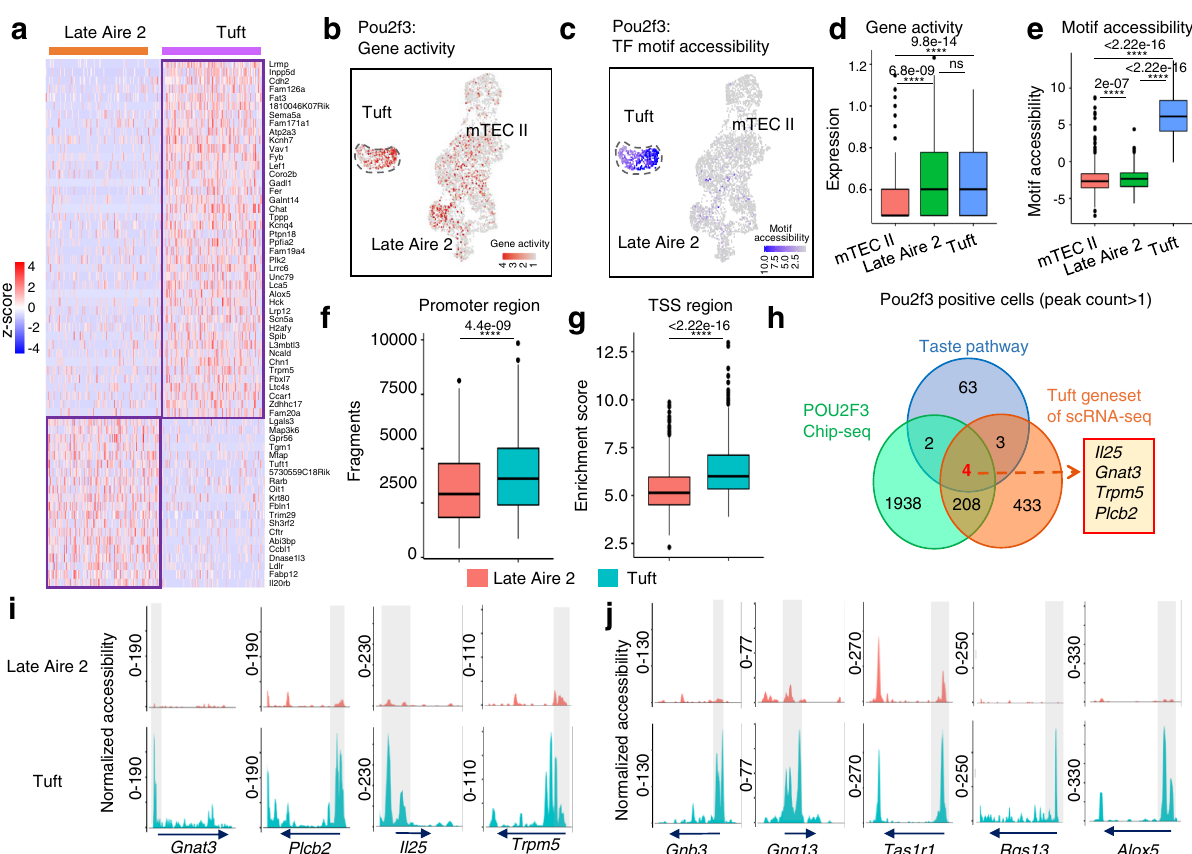
Fig. 3 Pou2f3 but not its target genes are expressed before Late Aire 2, and chromatin opening is required for target gene expression in thymic tuft cells. a Heatmap of differentially accessible genes between Late Aire 2 cells and thymic tuft cells in scATAC-seq. The color scale indicates the level of gene activity. b UMAP visualization of the gene expression of Pou2f3 in scRNA-seq. c UMAP visualization of the motif accessibility score of Pou2f3 in scATAC- seq. d Gene expression of Pou2f3 in Pou2f3 + mTEC subsets in scATAC-seq was compared in a boxplot. Pou2f3 + mTEC II: n = 499, Pou2f3 + Late Aire 2 cells: n = 210, Pou2f3 + thymic tuft cells: n = 297. e Motif accessibility score of Pou2f3 in Pou2f3 + mTEC subsets in scATAC-seq was compared in a boxplot. Boxplots show the fragments at the promoter region ( f ) and TSS enrichment score ( g ) for Late Aire 2 cells (pink) and thymic tuft cells (blue). Late Aire 2 cells: n = 551, thymic tuft cells: n = 495. h Taste pathway-related gene (blue), Pou2f3 directly regulated gene sets (green), and tuft gene sets of scRNA-seq (orange) are calculated in a Venn diagram. The overlapping genes among them are shown on the right. The chromatin accessibility peaks of overlapping genes ( i ) and tuft-associated genes ( j ) are shown in scATAC-seq tracks. The arrow indicates the length and direction of the genes detected by scATAC-seq. The statistics was determined using Wilcoxon signed-rank test. **** p <